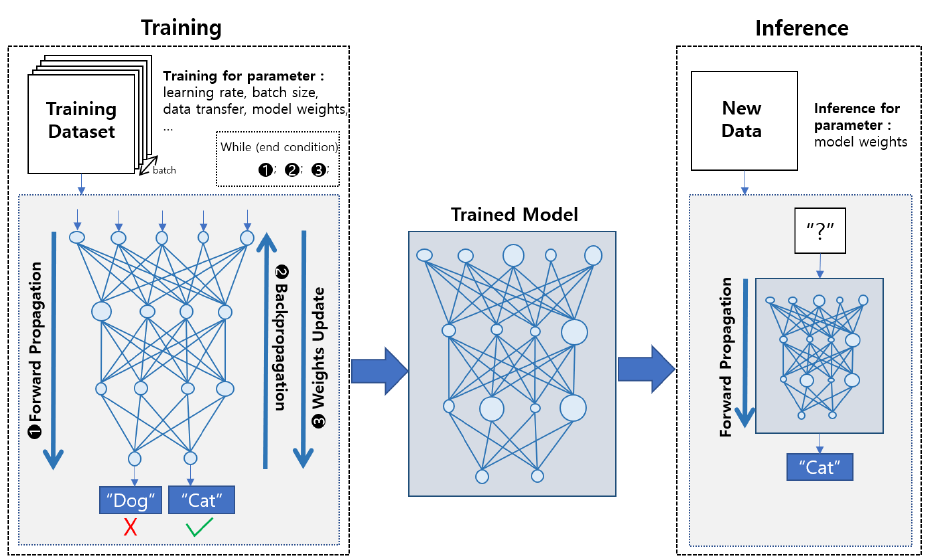
Figure 1. Conceptual illustration of the process of training and